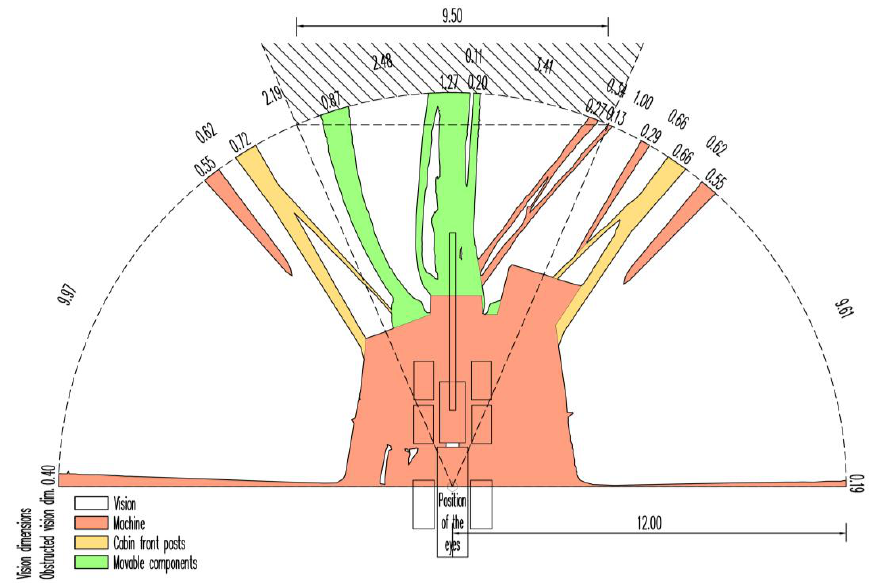
Figure 6. Semi-circular vision to the front of harvester driver determined by the TLS method. Note: dimensions are in m.